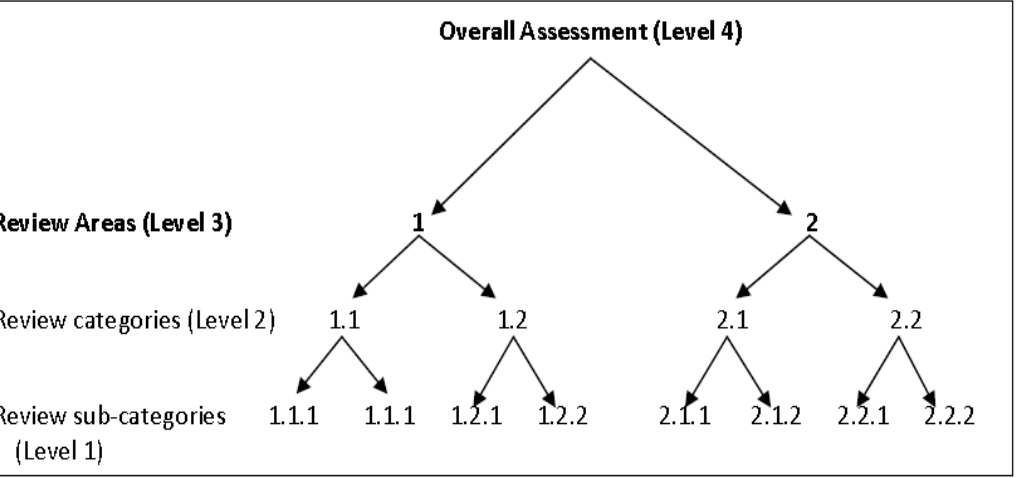
Figure 1. The original hierarchical Lee and Colley review package, but showing only two review areas, review categories, and review sub-categories. (Adapted from Lee et al. [ 74]).